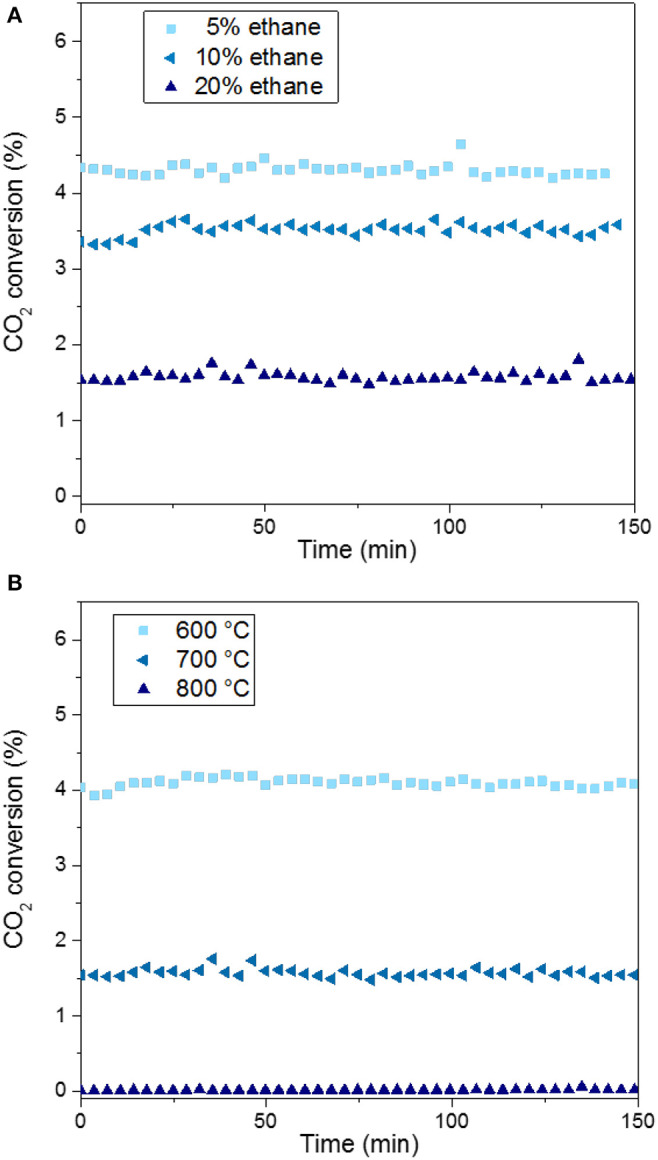
CO2 conversion over MoC/TiO2-P as a function of the amount of ethane used for carburization at 700°C (A) and the carburization temperature used for 20% ethane (B). Catalytic conditions: 400 mg of catalyst, 50 ml min−1, 250°C, 30 bar, H2:CO2 = 3:1, 150 min on stream after stabilization of the temperature.